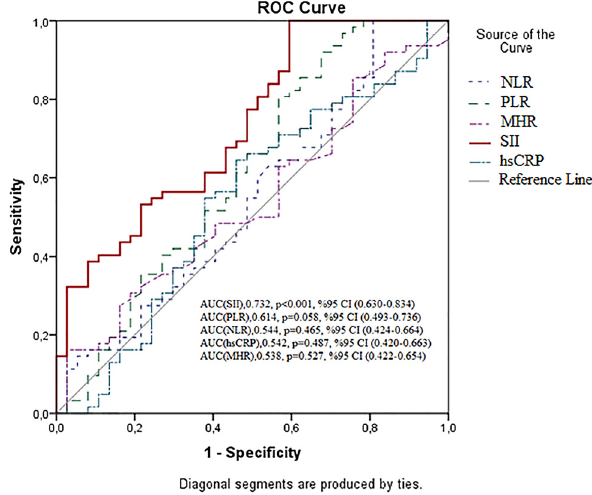
Figure 1: Receiver operating characteristics curve analysis for SII, NLR, PLR, MPR, MHR, hsCRP and WBC levels of patients with celiac